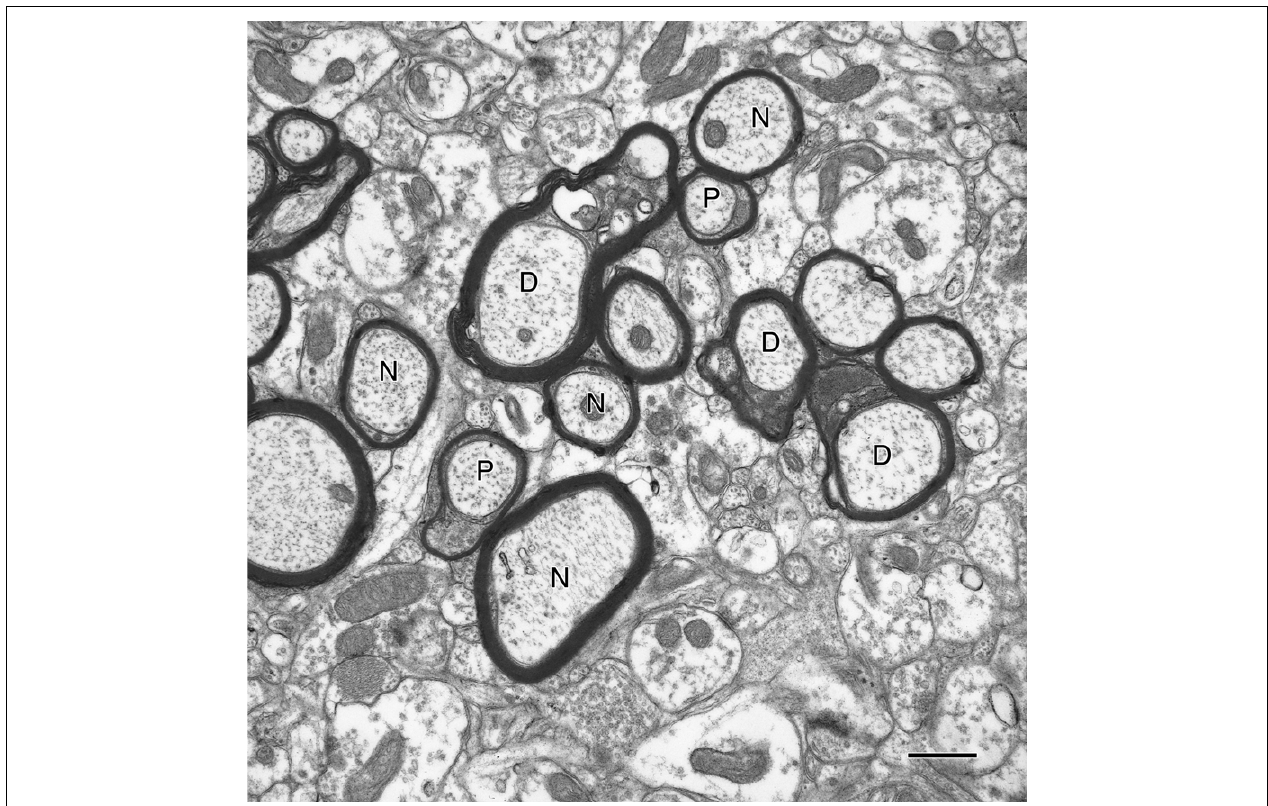
FIGURE 3 | A cross-sectioned nerve fi ber bundle in primary visual cortex of a 29-year-old rhesus monkey. In this bundle some of the nerve fi bers (N) have normal sheaths and are sectioned through internodes, and others (P) are